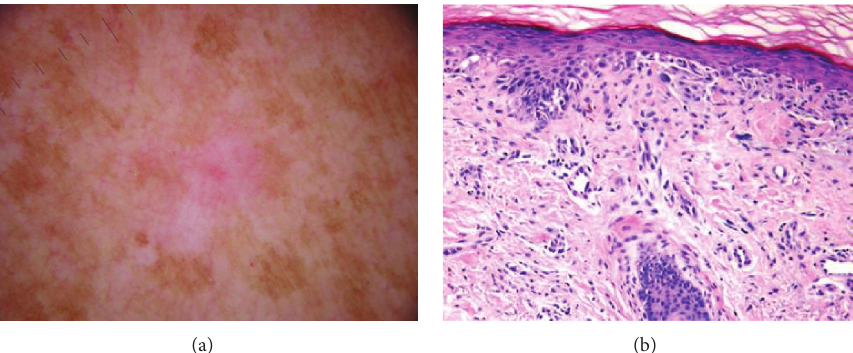
Figure 2: (a) Noncircumferential peripheral and central pink: completely amelanotic invasive melanoma, on right upper arm, 42-year-old female, depth 0.55mm, 5mm wide; patient had not noticed the lesion. Pink is present; pink rim sign is absent. (b) Histopathology for